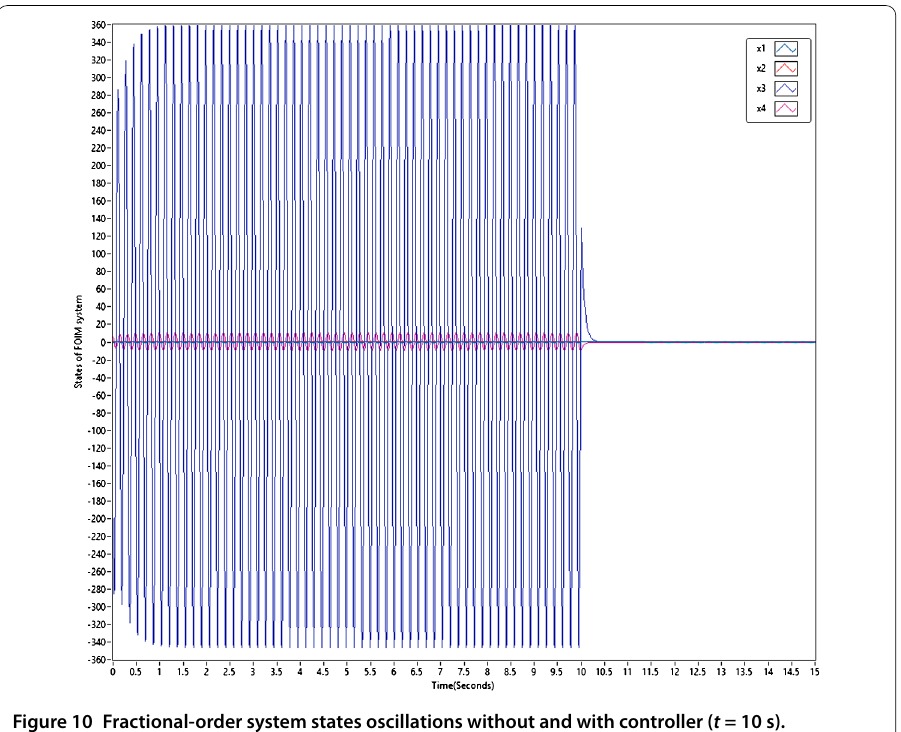
Figure 10 Fractional-order system states oscillations without and with controller ( t = 10 s).